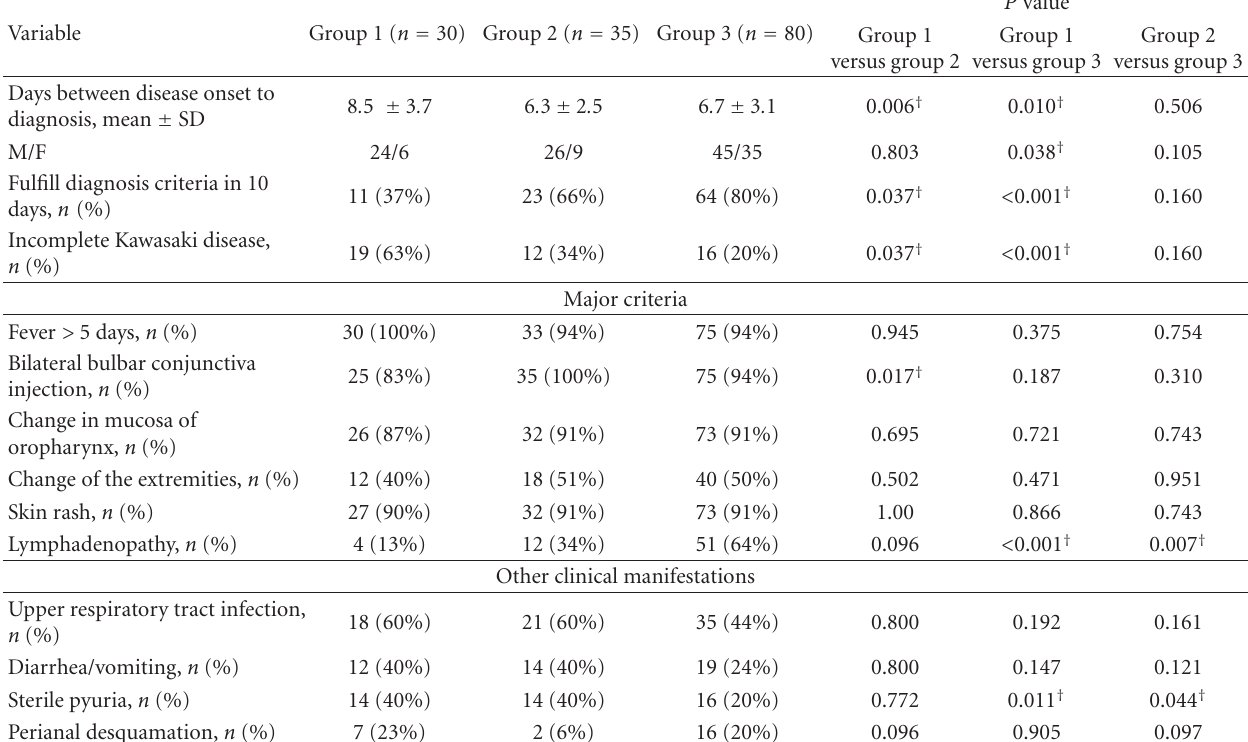
Table 1: Incidence and clinical